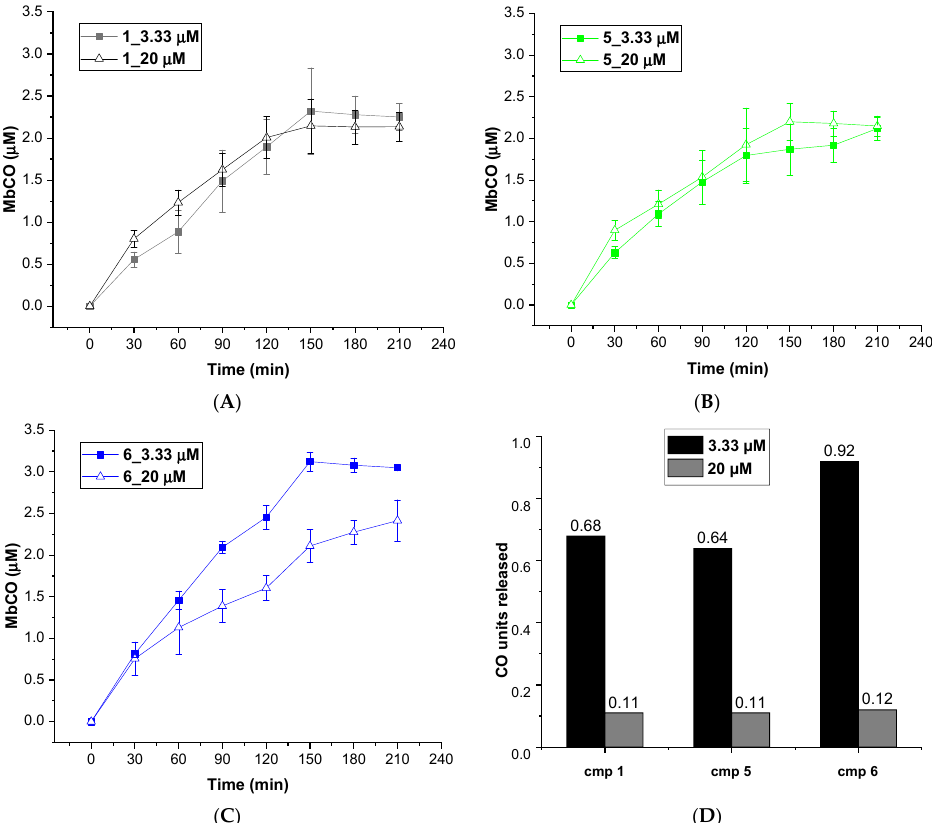
Figure 3. CO release profiles of compounds 1 ( A ), 5 ( B ) and 6 ( C ) analyzed at 1:6 (filled square) and 1:1 (empty triangles) CORM-Mb ratios; ( D ): CO units released by compounds 1 , 5 and 6 after 210 min of incubation working at 1:6 (blue columns) and 1:1 (orange columns) CORM-Mb ratios.